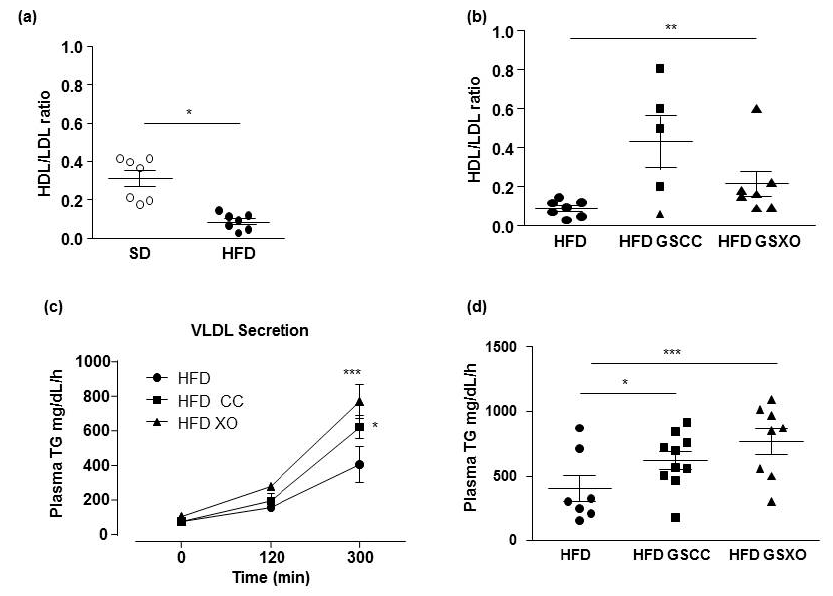
Figure 2. Effect of diet and apple supplementation on lipid parameters in ApoE-/- mice. Ratio of HDL- to LDL-cholesterol ( a , b ), very low density lipoprotein (VLDL) secretion ( c ) and VLDL secretion after 3 h ( d ) in mice receiving standard diet (SD; white circle), high fat diet (HFD; black circle), and HFD supplemented with apple for 14 weeks (black square and black triangle for HFD supplemented with GSCC and GSXO, respectively). The data were expressed as the mean ± SEM. Statistical analyses were performed by Mann–Whitney U tests, ( a ) one-way ANOVA, and post hoc analyses followed by Sidak correction ( b – d ), * p < 0.05, ** p < 0.01, *** p < 0.001.